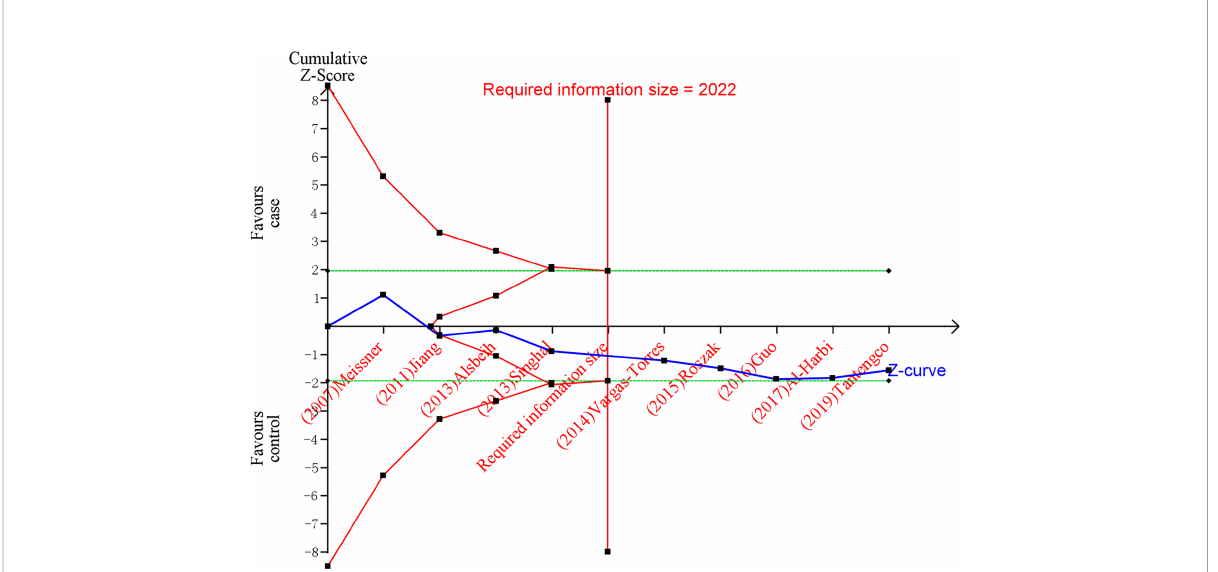
FIGURE 5 Estimation of the sample size for the relationship between MDM2 rs2279744 polymorphism and cervical cancer. Trial sequential analysis (TSA) is a methodology that includes a sample size calculation for a meta-analysis with the threshold of statistical signi fi cance. We performed a TSA using an allele model assumption but replaced the allele count with the sample size (divided by 2). Detailed settings: Signi fi cance level = 0.05; power = 0.80; ratio of controls to cases = 1; hypothetical proportion of effect allele in control = 0.37; least extreme OR to be detected = 1.5; I 2 (heterogeneity) = 74%.